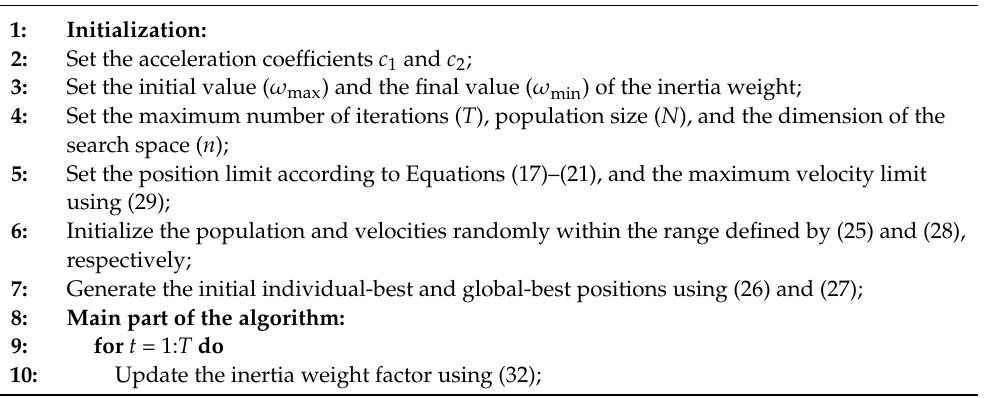
Algorithm 1 PSO Algorithm for Optimization Problem